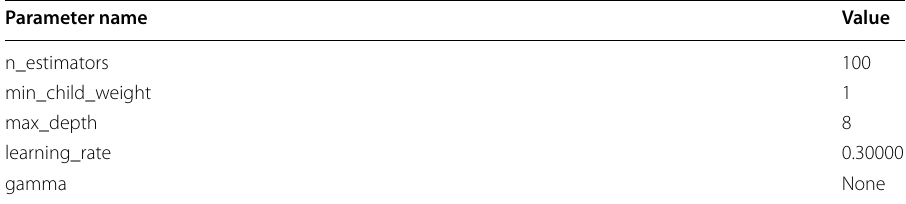
Table 69 Modes of XGBoost tuned hyperparameter values for experiments with the information theft dataset